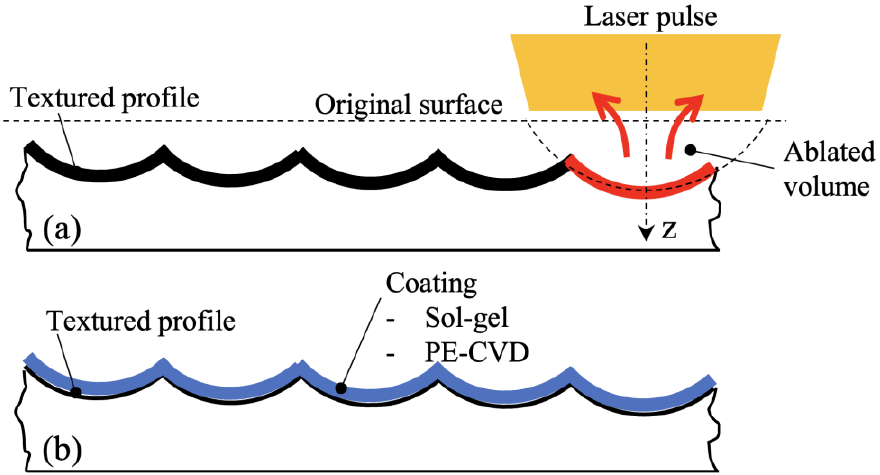
Figure 1. Schematic representation of proposed hybrid method: ( a ) Laser texturing; ( b ) subsequent coating treatment. coating